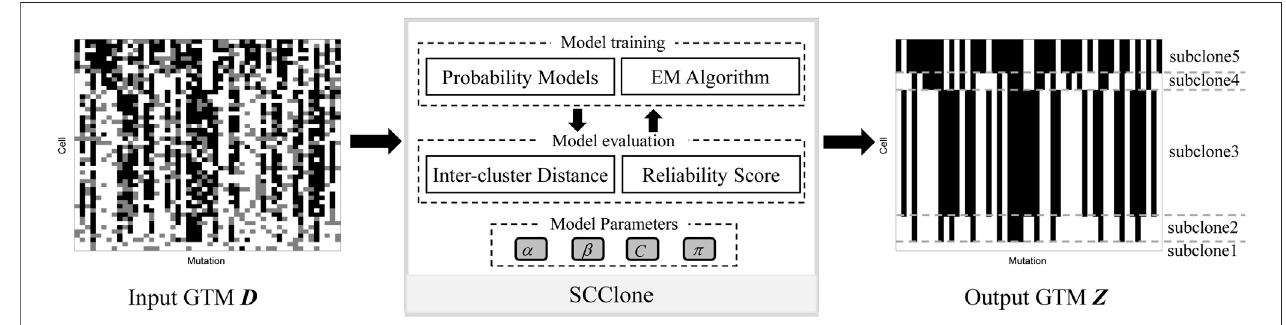
FIGURE1| SchematicoverviewoftheSCCloneframework.SCClonetakesnoisygenotype matrix D inferredfromscDNA-seqdataasinputandinfersthenumber ofsubclonesaswellasthegenotypesofeachsubclone.Eachelementof D ij denotesthestate(presence,absence,andunobserved)ofthe j thmutationinthe i thcell,and the different states are marked by black, white, and gray,